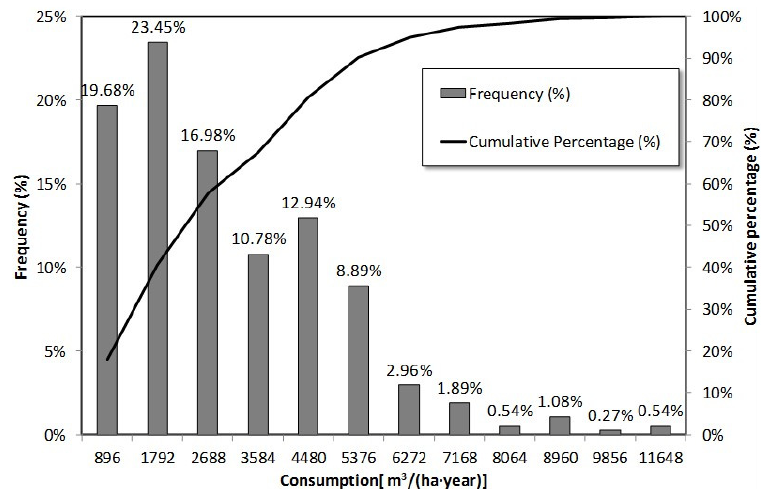
Figure 7. Distribution of annual consumptions in Vallada case study. Water 2016 , 8 , 234